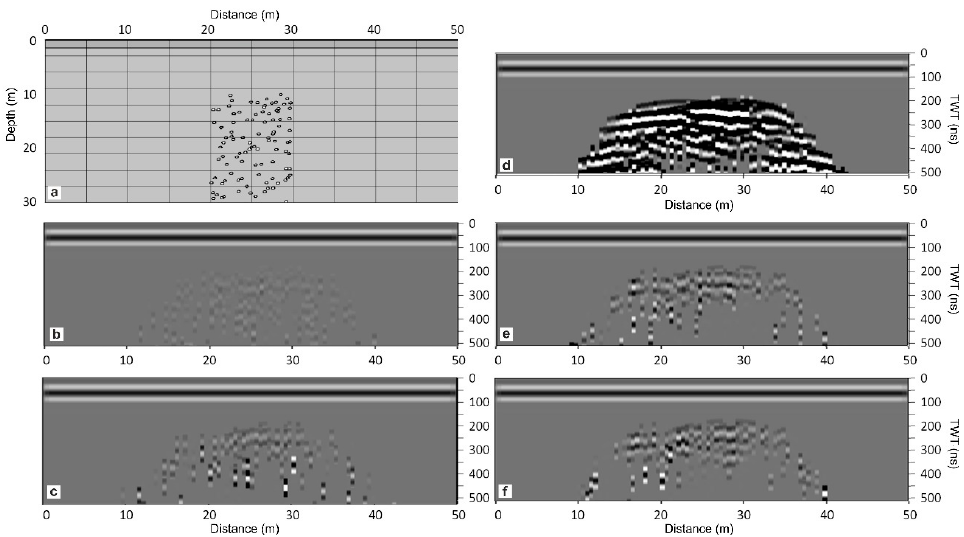
increase of the backscattering amplitude is noticeable, depending on the radius (Figure 8c,e,f).